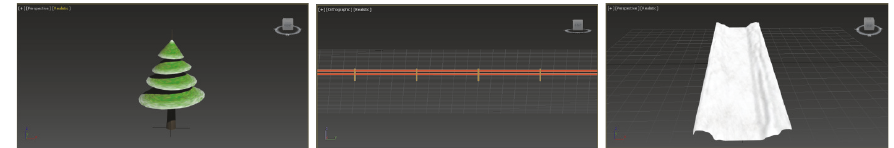
Figure 17: Static scenery game objects are composed by trees, fences and the game terrain.